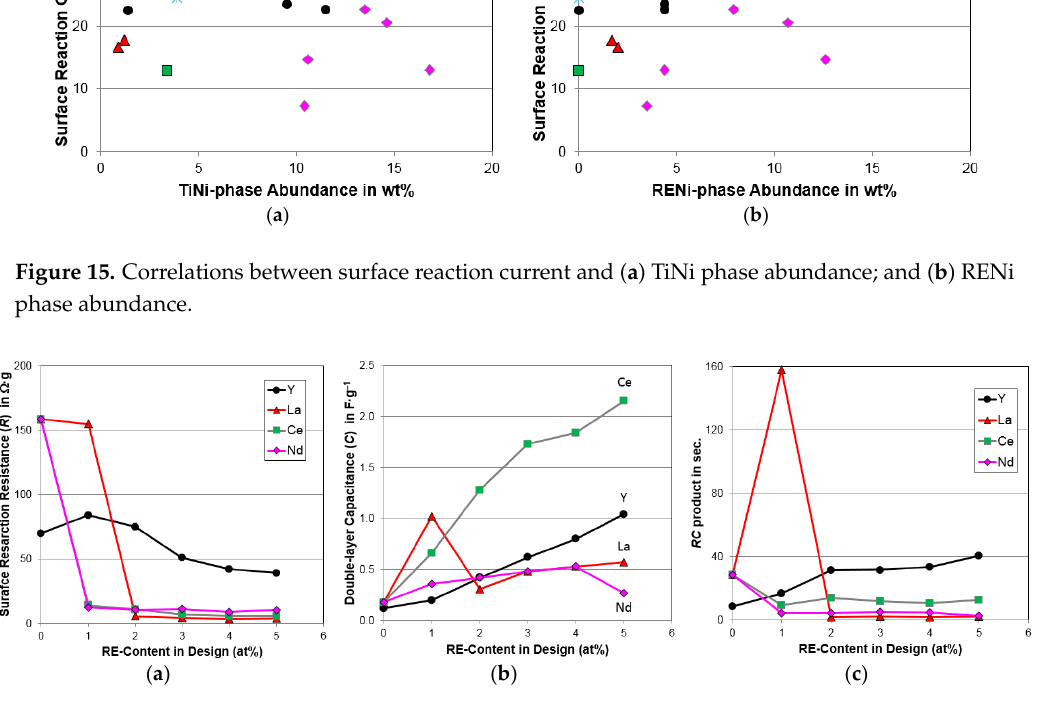
Figure 16. Evolutions of ( a ) surface charge-transfer resistance; ( b ) double-layer capacitance calculated from the AC impedance results measured at − 40 °C; and ( c ) their product with increasing RE-content in the design.